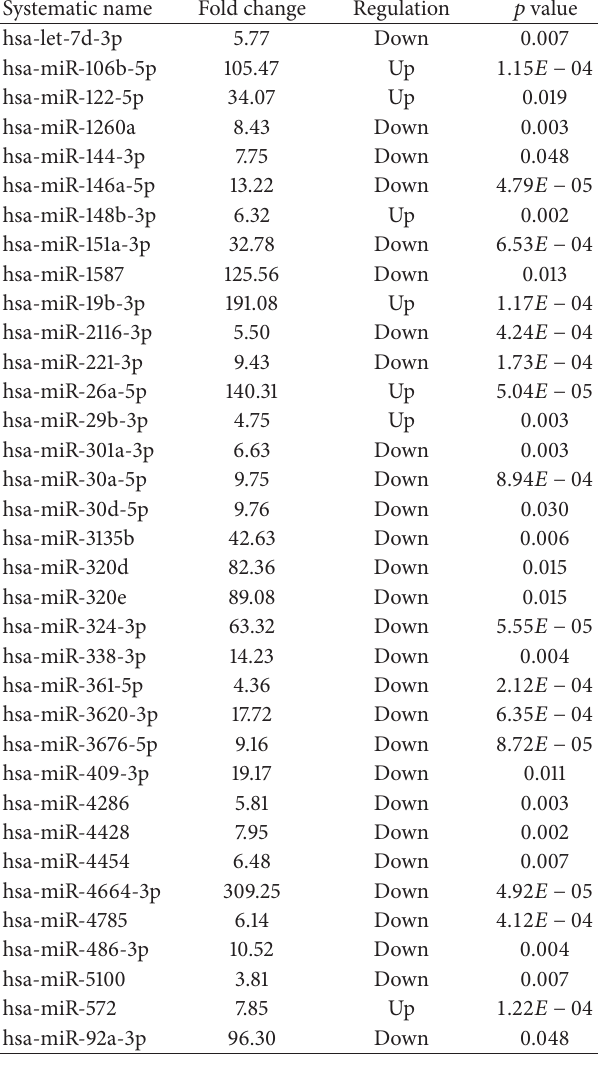
Table 3: Differentially expressed miRNAs in T2DM with D-IBS compared with D-IBS and T2DM.